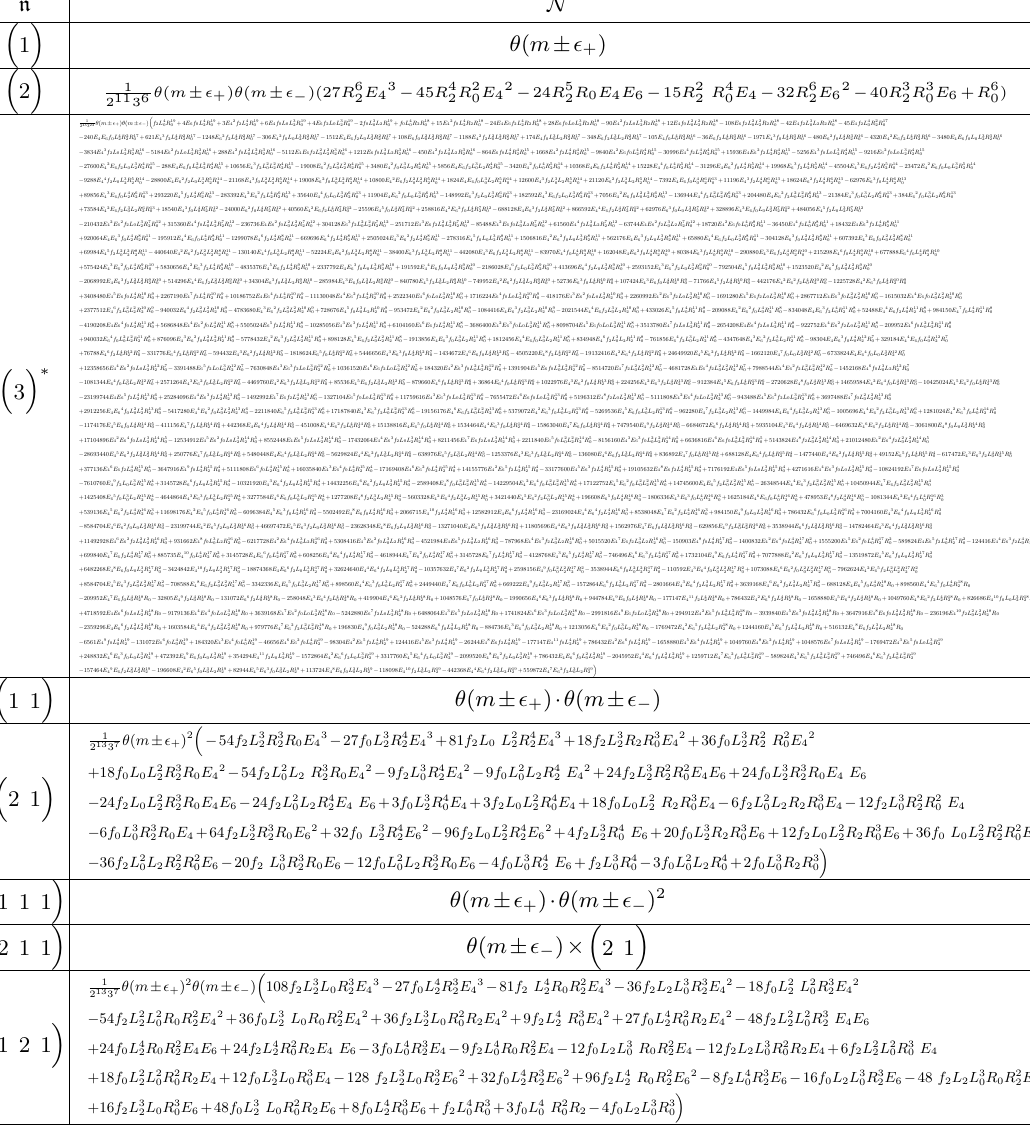
Table 3 . Elliptic genera of A 1 , 2 , 3 . The result that cannot be obtained from the flip symmetry is marked with the